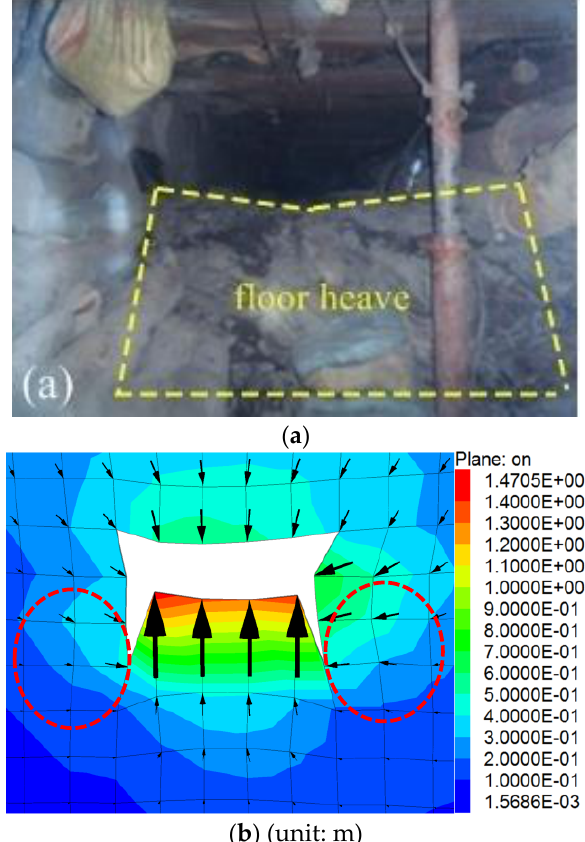
Figure 8. Comparison of real RGSG profile ( a ) and simulated RGSG profile ( b ).